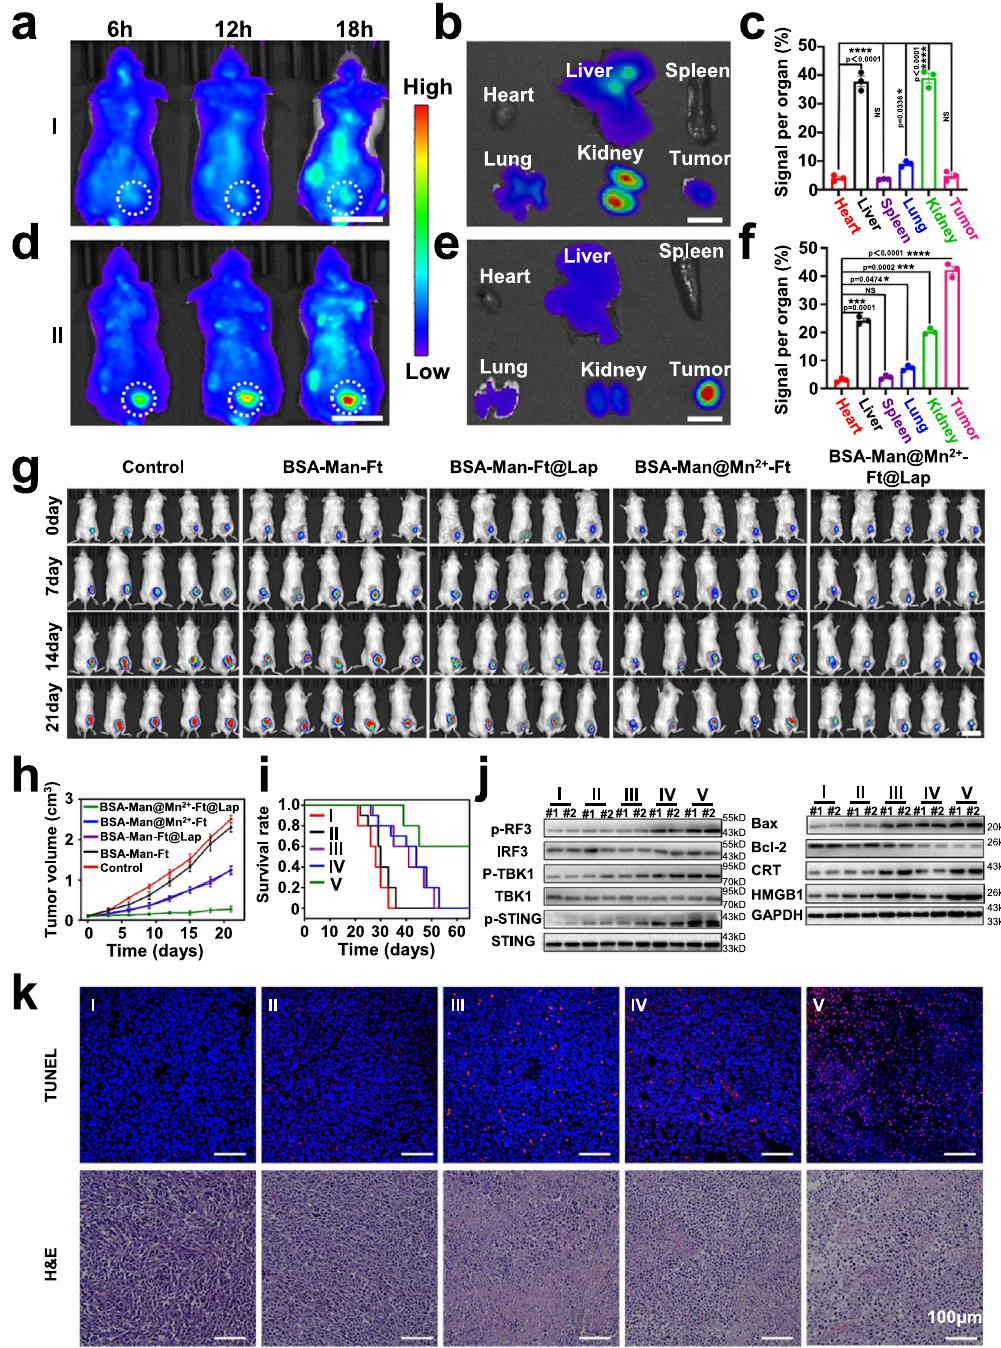
Fig. 6 | BSA-Man@Mn 2+ -Ft@Lap nanoassembly was selectively activated in solid tumors to induce potent immune response for tumor suppression. a , b , d , e Panels a , d are the systemic distribution of the samples at 6/12/18h